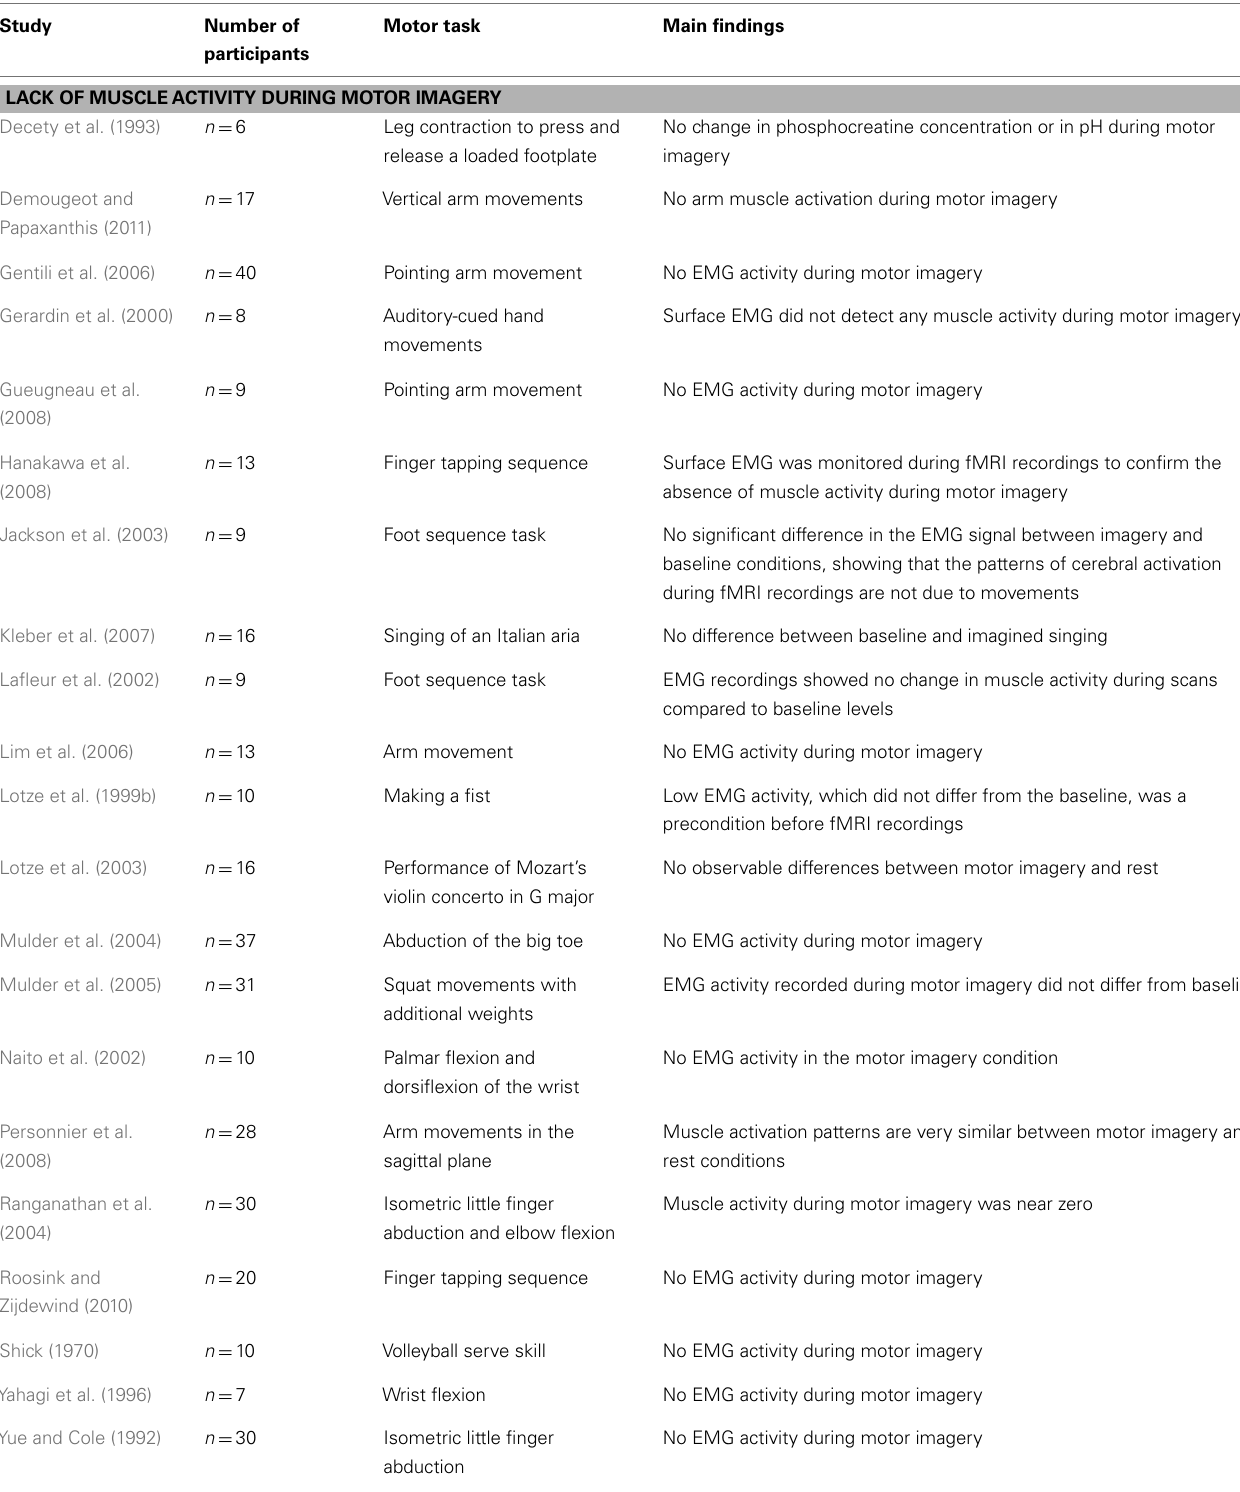
Table 1 | Studies investigating the EMG activity during motor